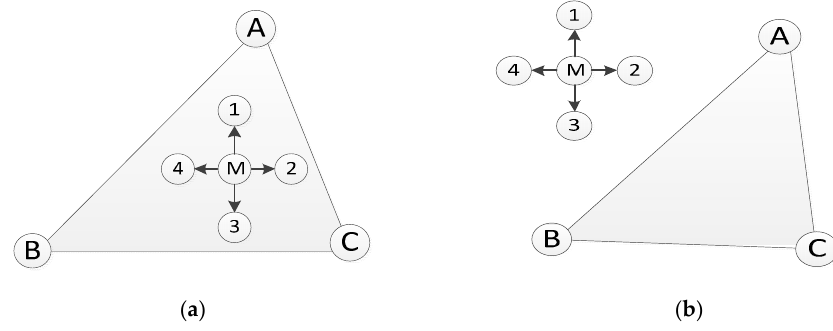
Figure 5. APIT localization test principle schematic. ( a ) M is in the triangle; ( b ) M is out of the triangle. Step 3: Acquire triangles’ overlapping